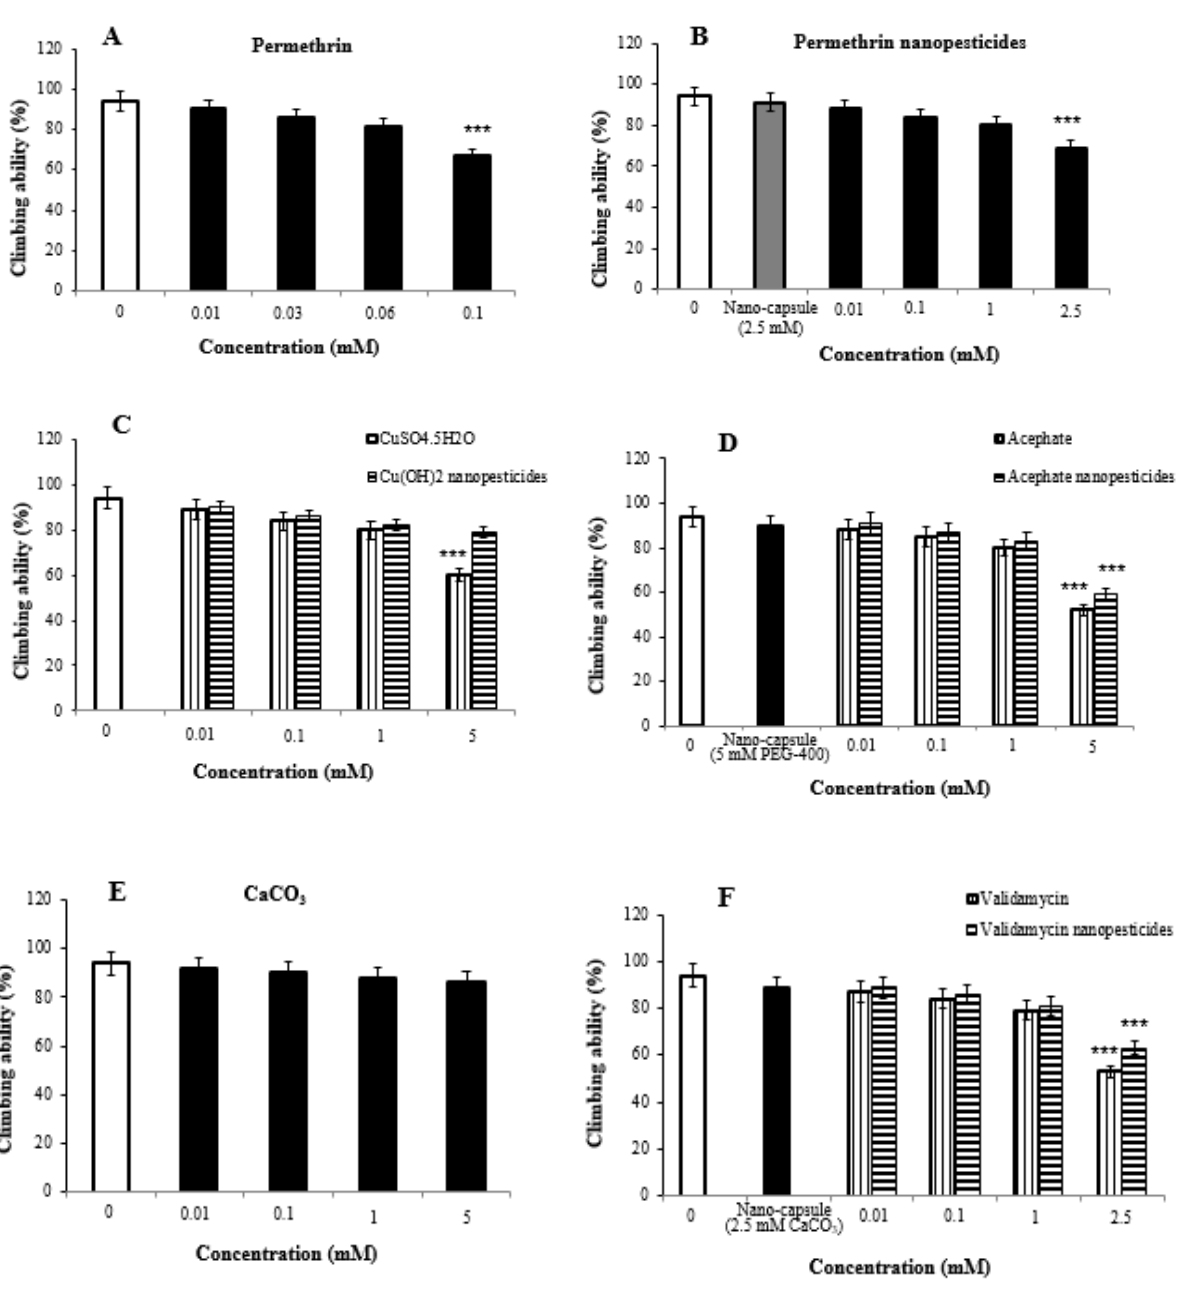
Figure 5. Climbing behavior of flies monitored after seven days of exposure to permethrin ( A ), permethrin nanopesticides ( B ), CuSO 4 · 5H 2 O and Cu(OH) 2 nanopesticides ( C ), acephate and acephate nanopesticides ( D ), CaCO 3 ( E ), and validamycin and validamycin nanopesticides ( F ), recorded after 10 s. Data represent the mean ± standard error (SE) of the mean; *** p ≤ 0.001 when compared to the negative control by one-way ANOVA.